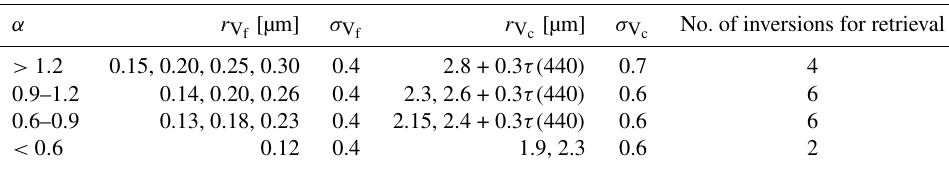
Table 2. Multiple initial guess values for the volume mode radii used in the GRASP-AOD application. The choices depend on the Ångström exponent, which characterizes the dominant mode.